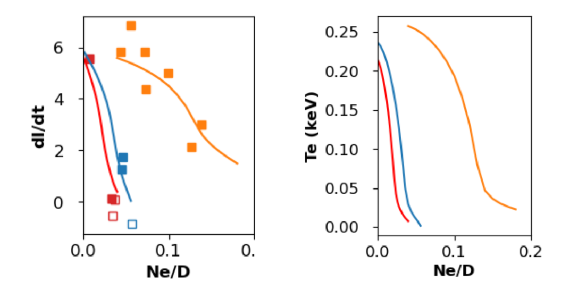
Figure 10. After 90 ms of simulation, red: Ohmic; Blue: EC: 0.7 MW; Orange: EC 1.4 MW. (Left) Comparison between plasma current development as a function of Ne concentration: experi- mental data (squares), simulation (line). (Right) simulation of T e as a function of